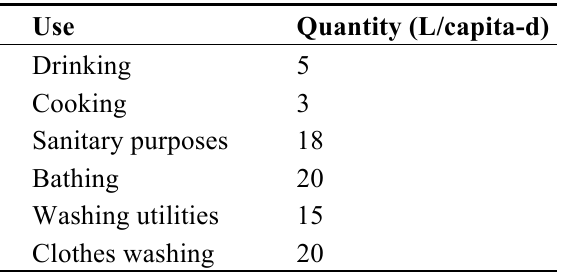
Table 3. Usage data from Southern Asia [20].